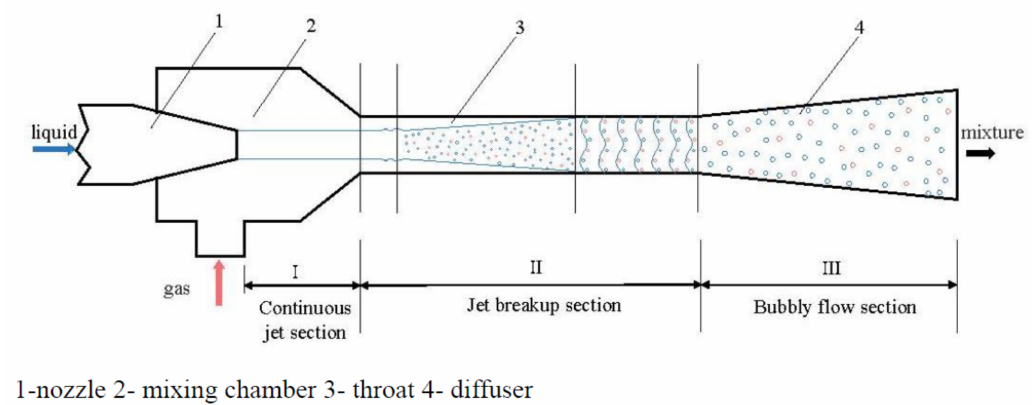
Figure 1. Working principle and structure diagram of the LGJP.